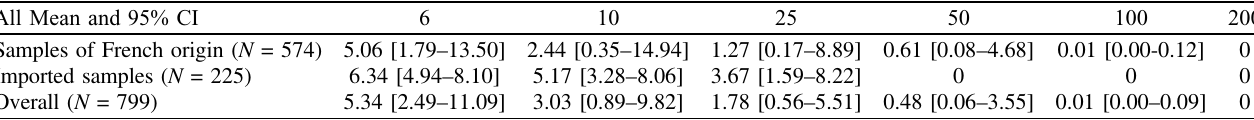
Table 3. The overall seroprevalence of Toxoplasma gondii infection in calves consumed in France accordingly to the terminal titer (6; 10; 25; 50; 100; 200).